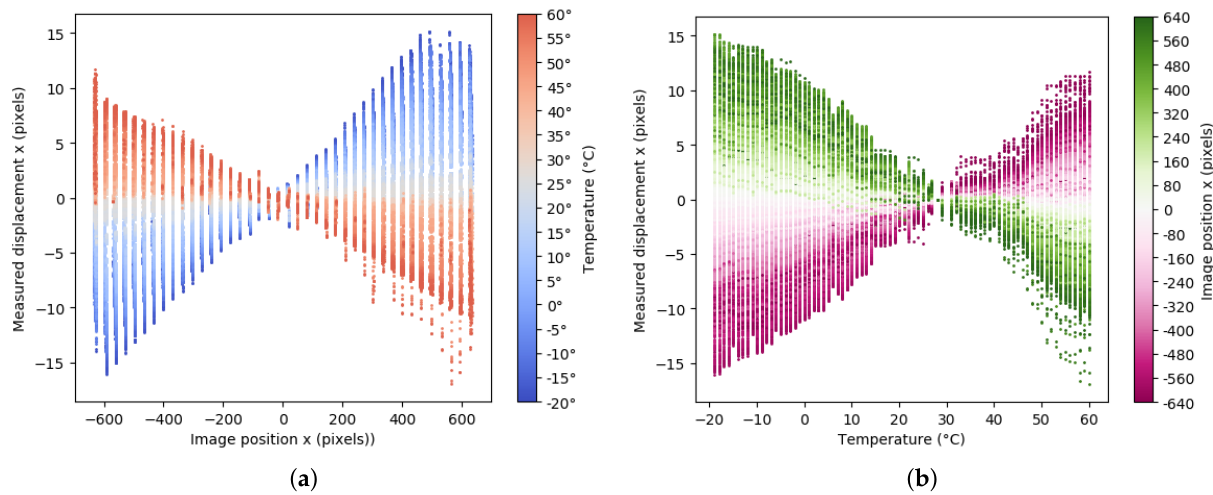
Figure 5. The infrared (IR) image distortion in function of ( a ) the horizontal position in the image and ( b ) the temperature. The different temperatures and displacements are shown using a color